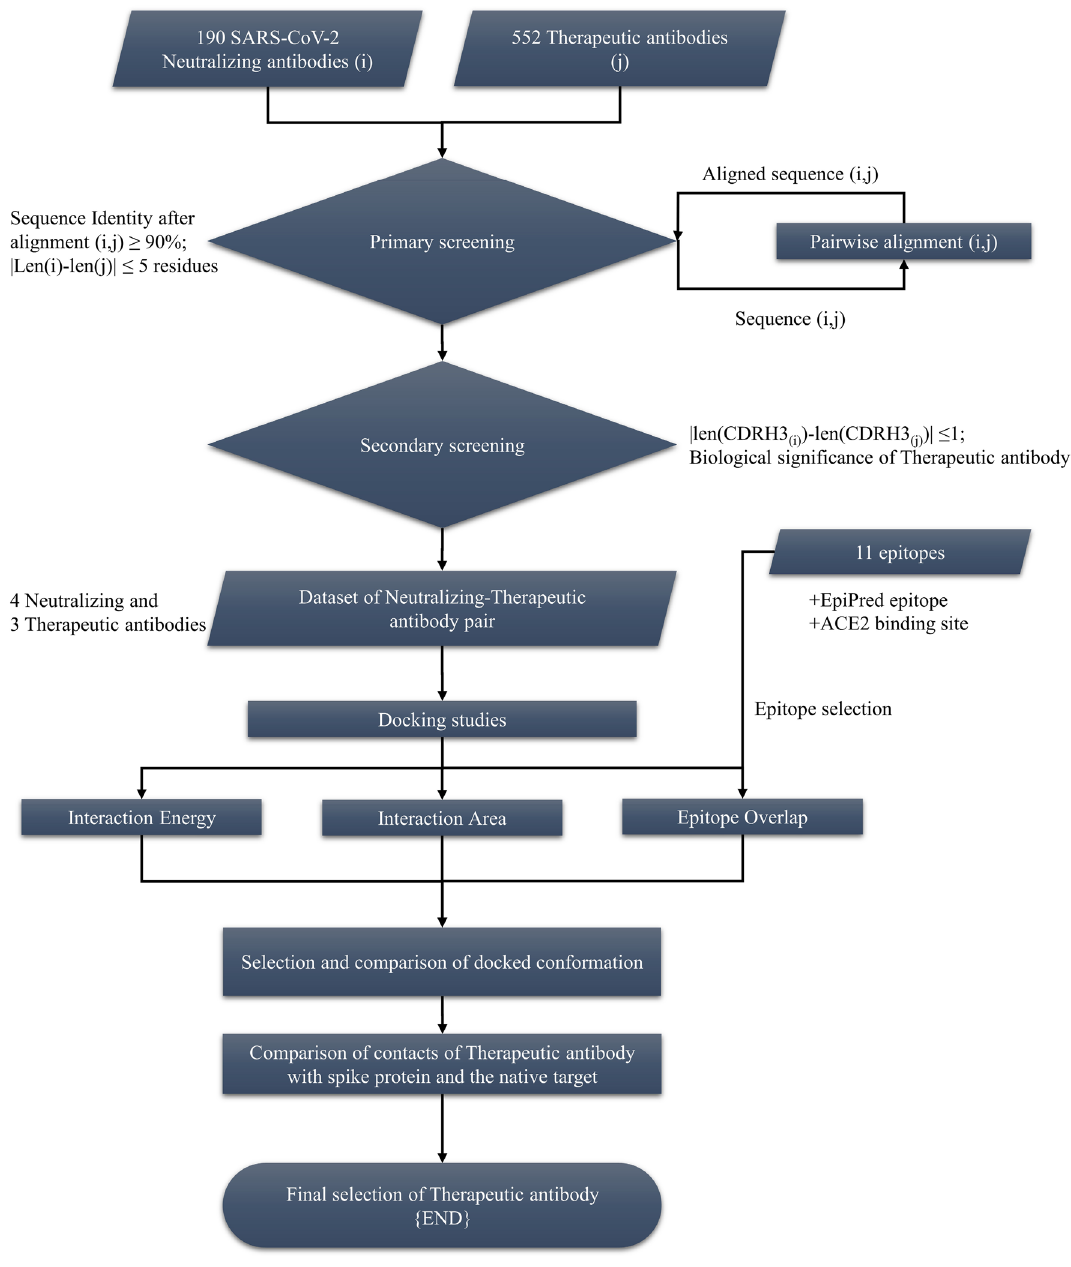
Figure 1. Workflow illustrating the steps followed to screen therapeutic antibodies for potential repurposing against is close (± 4 amino acid residues) to the average epitope length on the spike protein (~ 22 amino acid residues, from “known epitope dataset”) to avoid inclusion of too short and/or long epitopes and (3) overlap with the ACE2 binding site for potential virus neutralization ability. This procedure yielded three potential epitopes, CB6, S2H14 and S2H13 (Table S5, Figure S4). Docking studies and antibody‑SARS‑CoV‑2 spike protein complex analysis. We have carried out molecular docking using ClusPro 2.0 35 and generated the structures (30 conformations each) of SARS-CoV-2 spike protein complexed with both SARS-CoV-2 specific neutralizing antibodies and therapeutic antibodies. The optimal docked conformation was selected for each SARS-CoV-2 spike protein-antibody complex based on (1) binding to unique epitopes in “known epitope dataset” (maximum overlap), (2) interaction energy and (3) interaction area. The interaction energies of the docked structures at chosen conformations were calculated using FoldX 36 . Accessible surface areas of the RBD region in the spike protein (S E ), antibody ( S H + L ) as well as